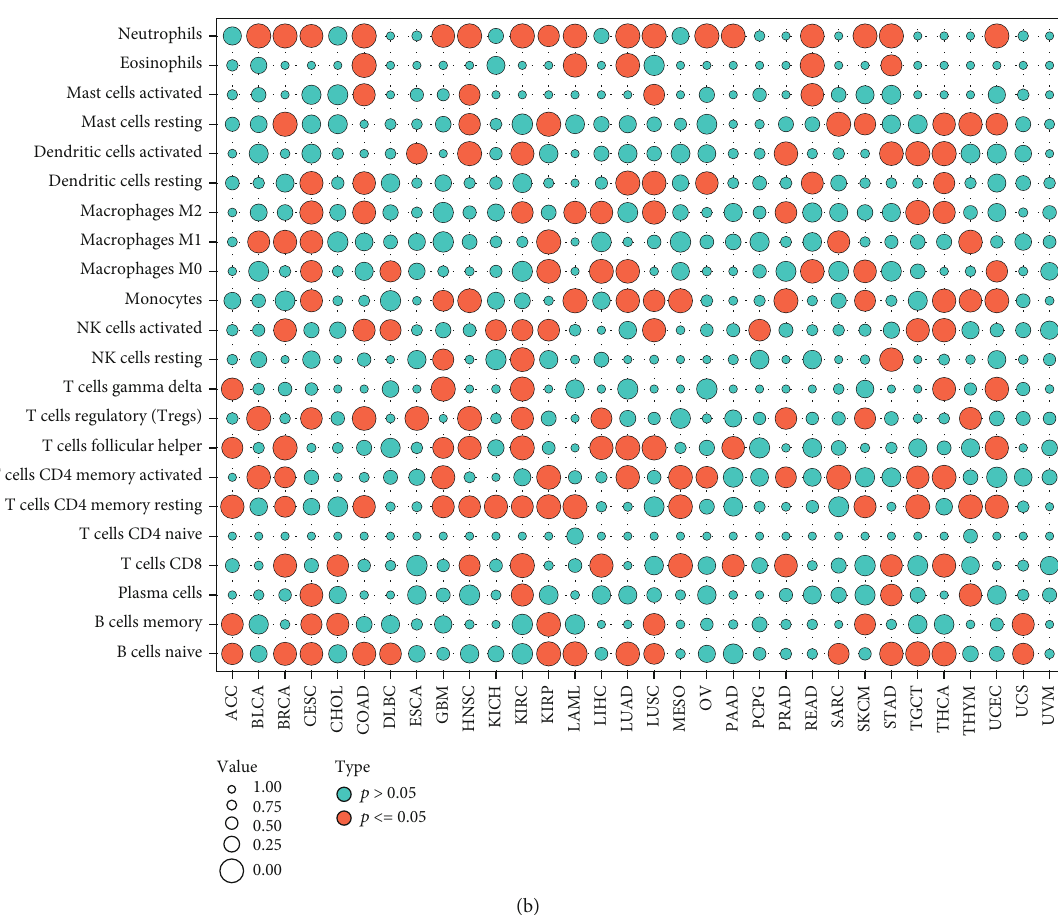
Figure 6: The correlation between the expression level of BACE1-AS and immune cell in fi ltration analysis in pan-cancers. (a) Correlation analysis between immune cells. The blue circle shows a negative correlation between the two genes, while the red circle shows a signi fi cant positive correlation. (b) Correlation of BACE1-AS expression with immune cells in pan-cancer. The red circles indicated BACE1-AS expression was signi fi cantly correlated with immune cells, while the blue circles indicated no